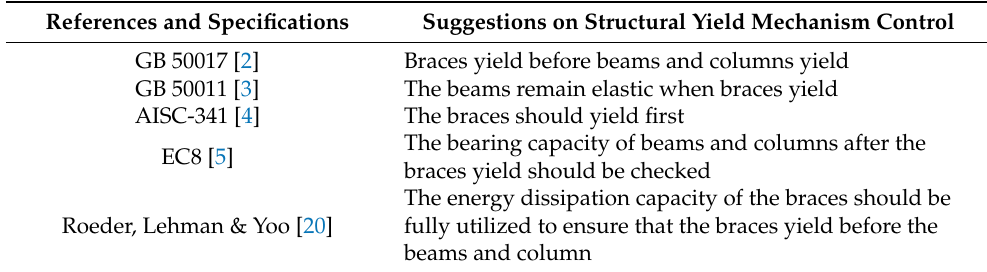
Table 1. Suggestions on structural yield mechanism control in References and